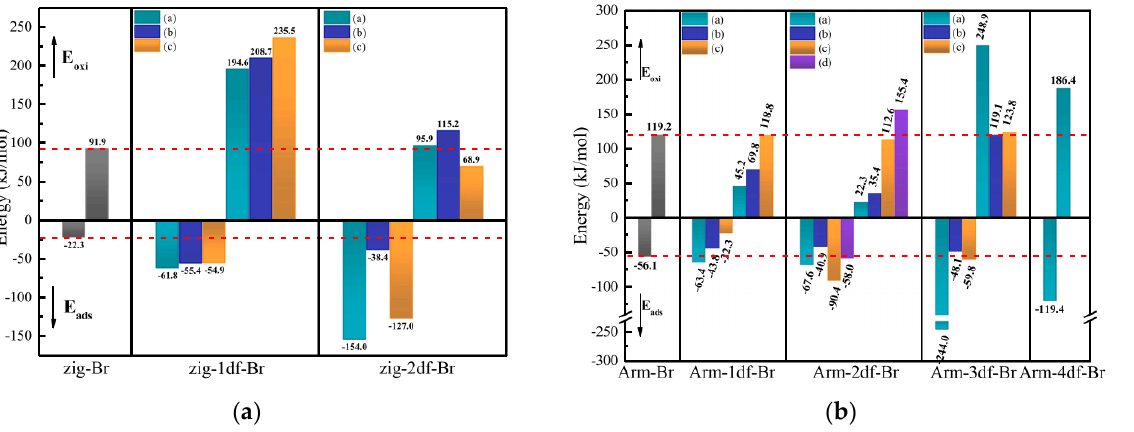
Figure 11. The summary of mercury adsorption energy and oxidation barrier on ( a ) Zigzag, and ( b ) Armchair [71] . Reprinted/adapted with permission from Ref. [71]. 2022, Journal of Hazardous Ma- terials.